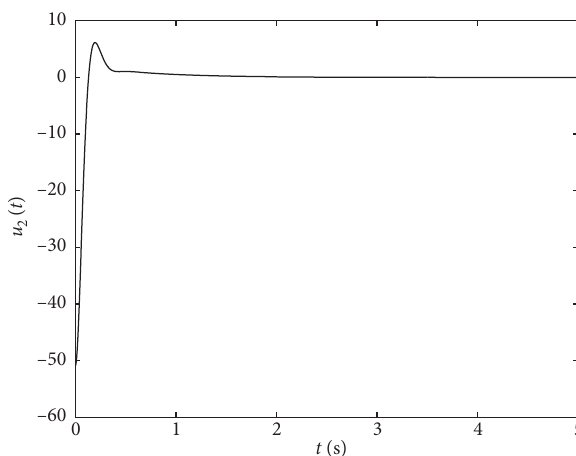
Figure 7: Control curve u connected